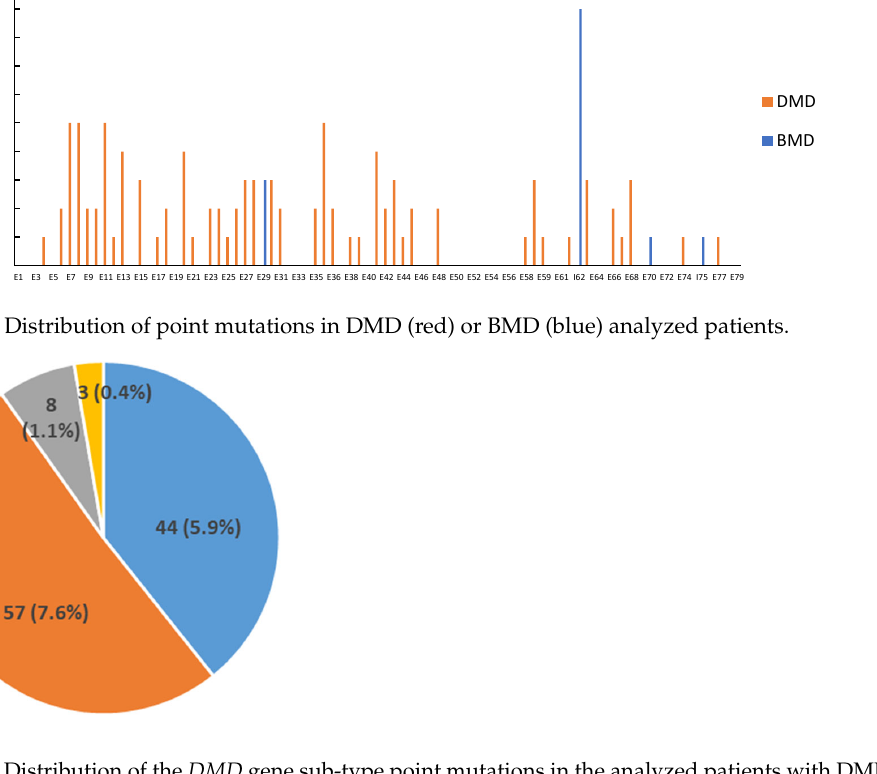
Figure 3. Number of times each individual exon of the DMD gene was involved in a deletion ( A ) or duplications ( B ) in the 719 patients with DMD or BMD. Point mutations were identified in 112 (14.9%) patients, without preferential hotspots (Figure 4). They were distributed as follows: 44 (5.9%) were small ins/del causing a frame ‐ shift, 57 (7.6%) were nonsense mutations, 8 (1.1%) were splice sites, and 3 (0.4%) were intronic mutations (Figure 5).